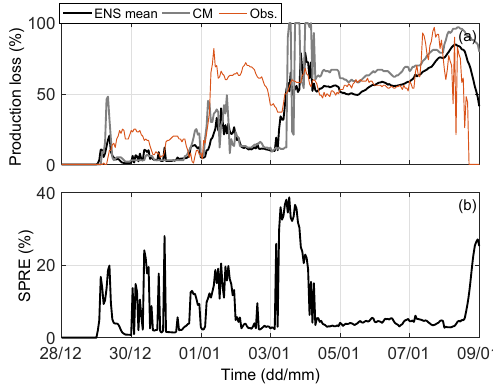
Figure 10. Same as Fig. 7, but for Site